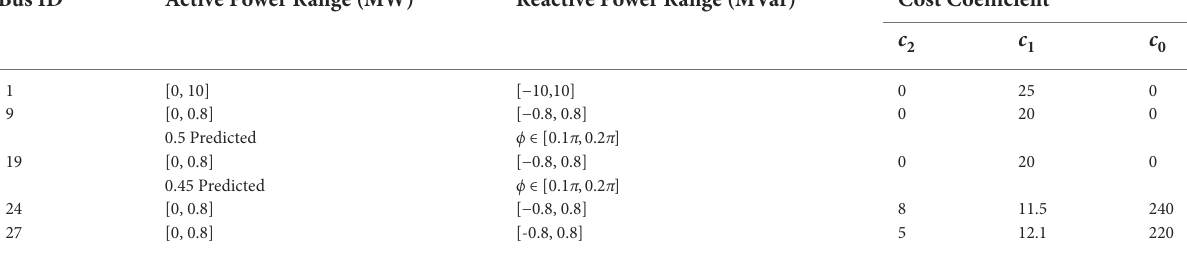
TABLE 1 Parametersofpowergenerationunits.